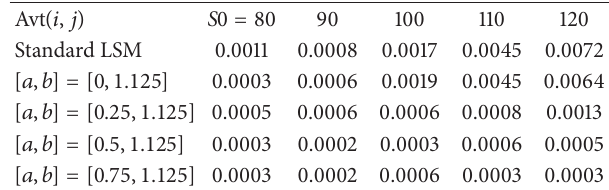
Table 6: Numerical result for Example 5.